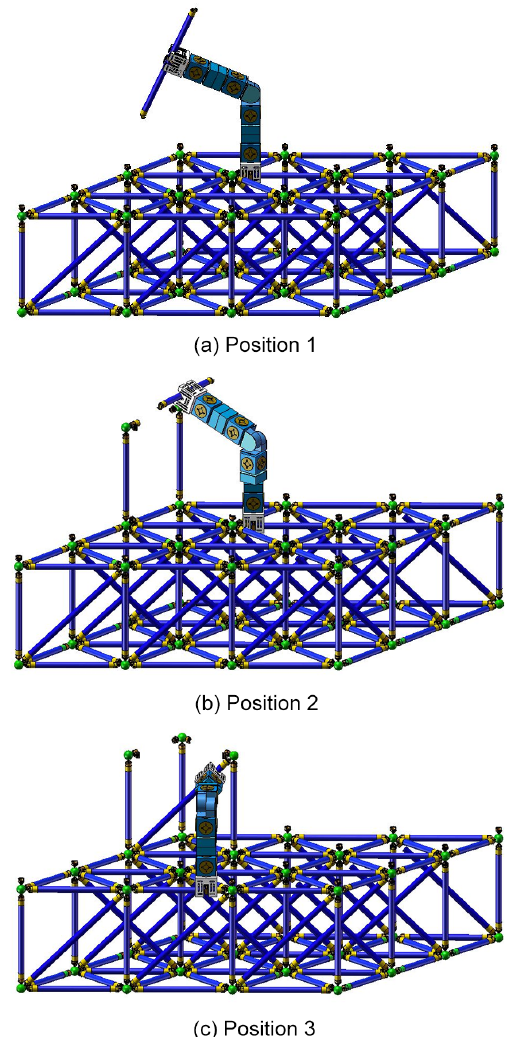
Figure 15. Truss assembly experiment